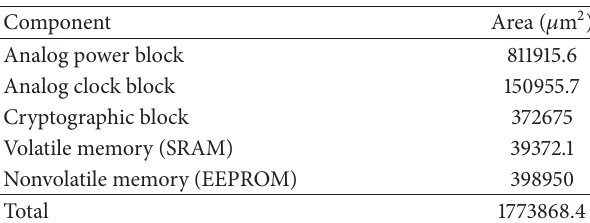
Table 2: Area of blocks on the RFID tag chip after